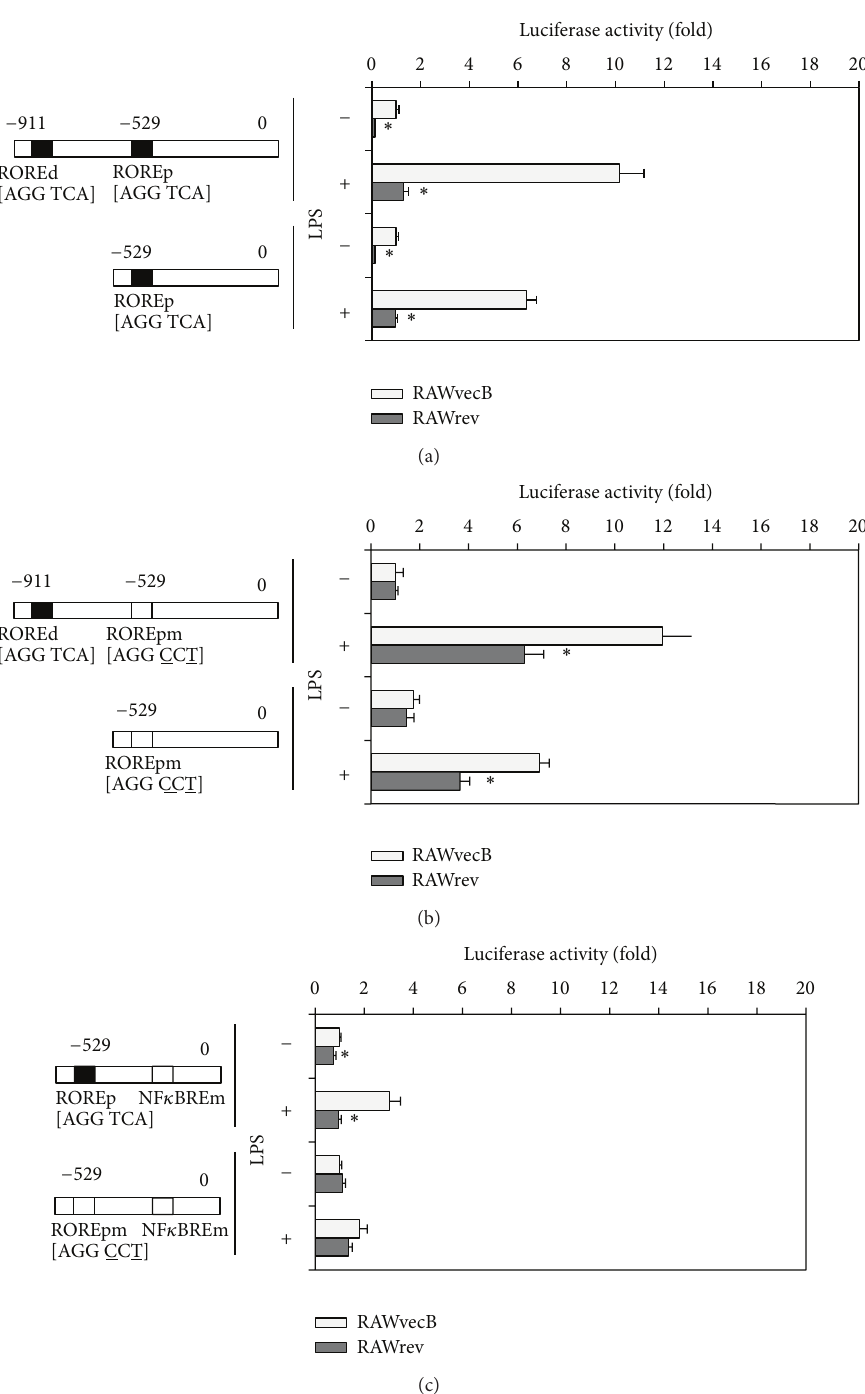
Figure 3: REV-ERB 𝛼 represses il6 promoter activity, independent of the inhibition of NF 𝜅 B signaling. (a) RAWrev and RAWvecB cells were transiently transfected with luciferase reporter construct containing either a distal or a proximal construct of il6 promoter. After treatment with or without 1 𝜇 g/mL LPS for 24 h, luciferase activities were determined. ROREd, distal RORE; ROREp, proximal RORE. (b) The AGGTCA half-site in the proximal RORE was changed to AGGCCT by site-directed mutagenesis of nucleotides − 518 (A to T) and − 520 (T to C), and luciferase activities of each cell either untreated or treated with LPS for 24h were determined. ROREpm, proximal RORE mutant. (c) The GGGATTTTCC half-site in the NF 𝜅 BRE was changed to GGGCCCTTCC by site-directed mutagenesis of nucleotides − 86 (T to C), − 87 (T to C), and − 88 (A to C), and luciferase activities of each cell either untreated or treated with LPS for 24 h were determined. NF 𝜅 BREm, NF 𝜅 BRE mutant. Luciferase values were normalized using Renilla luciferase. The data are presented as the means ± S.E. from sextuplicate cultures. ∗ 𝑃 < 0.05 versus vector